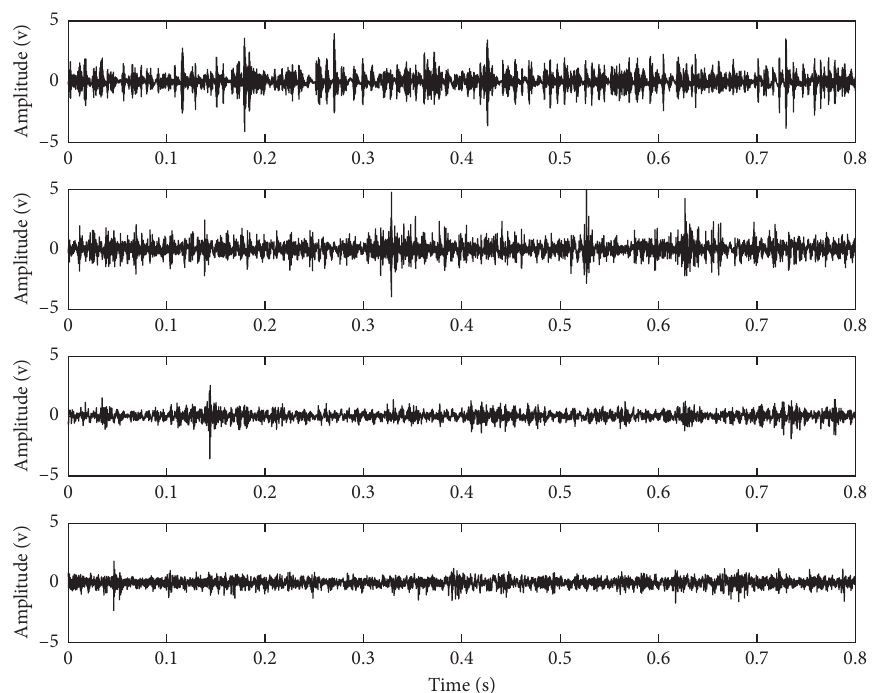
Figure 20: The 4 separated signals using SCA